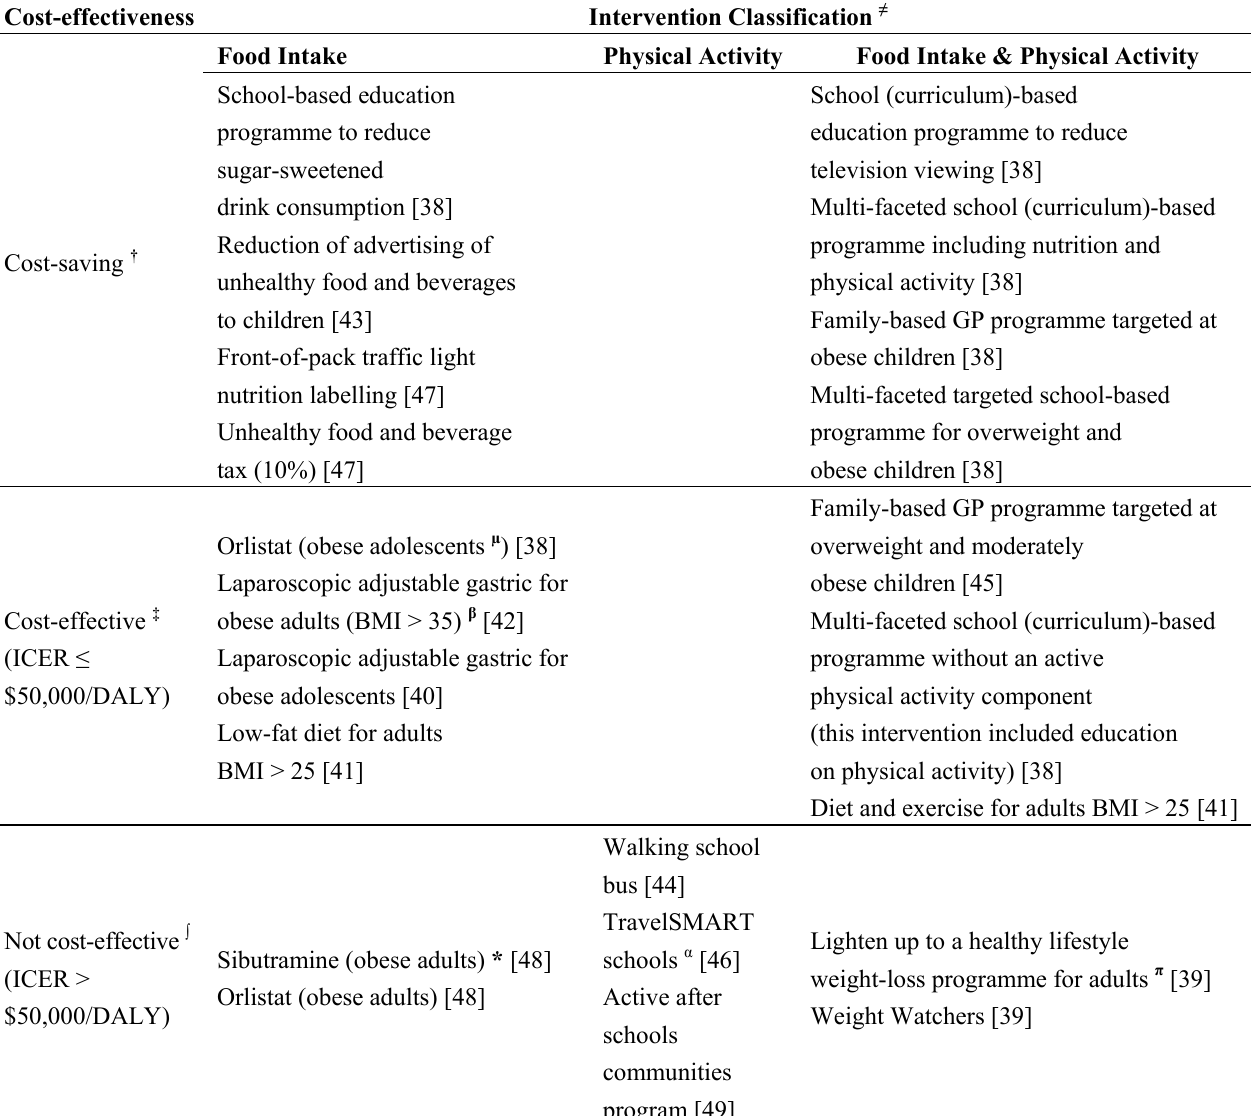
Table 3. Cost-effectiveness of interventions aimed at food intake and physical activity from the Assessing Cost-Effectiveness (ACE)-Obesity and ACE-Prevention